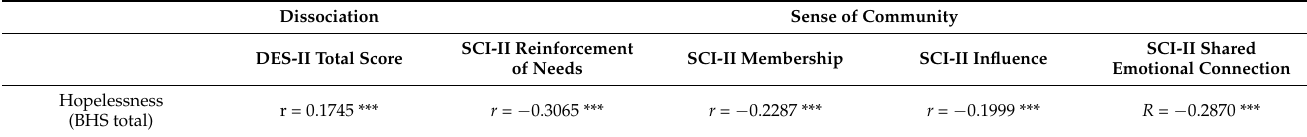
Table 2. Correlations (Pearson’s r) performed between hopelessness (Beck Hopelessness Scale (BHS) total score), dissociation (Dissociative Experiences Scale II (DES-II) total score), and sense of community (sense of community index II (SCI-II) subscales; Reinforcement of Needs, Membership, Influence, and Shared Emotional Connection) ( n = 461).